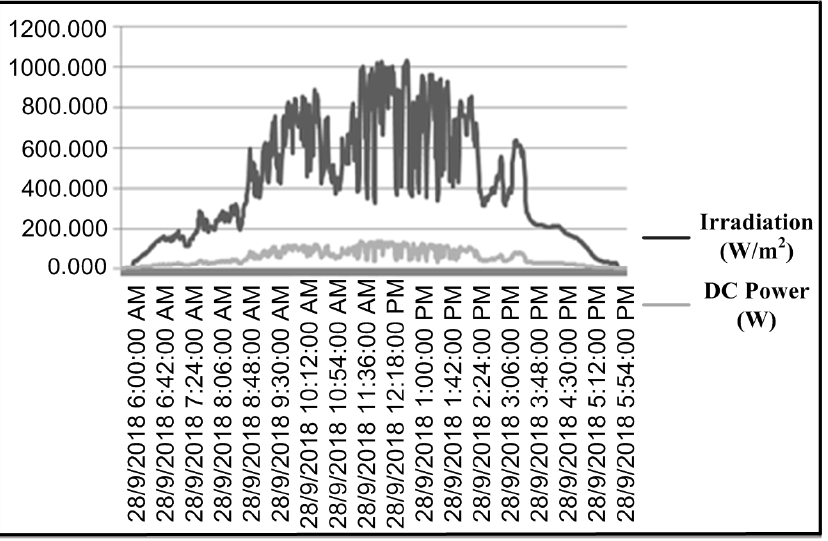
Figure 3. Irradiation and PV power for severe solar variability.